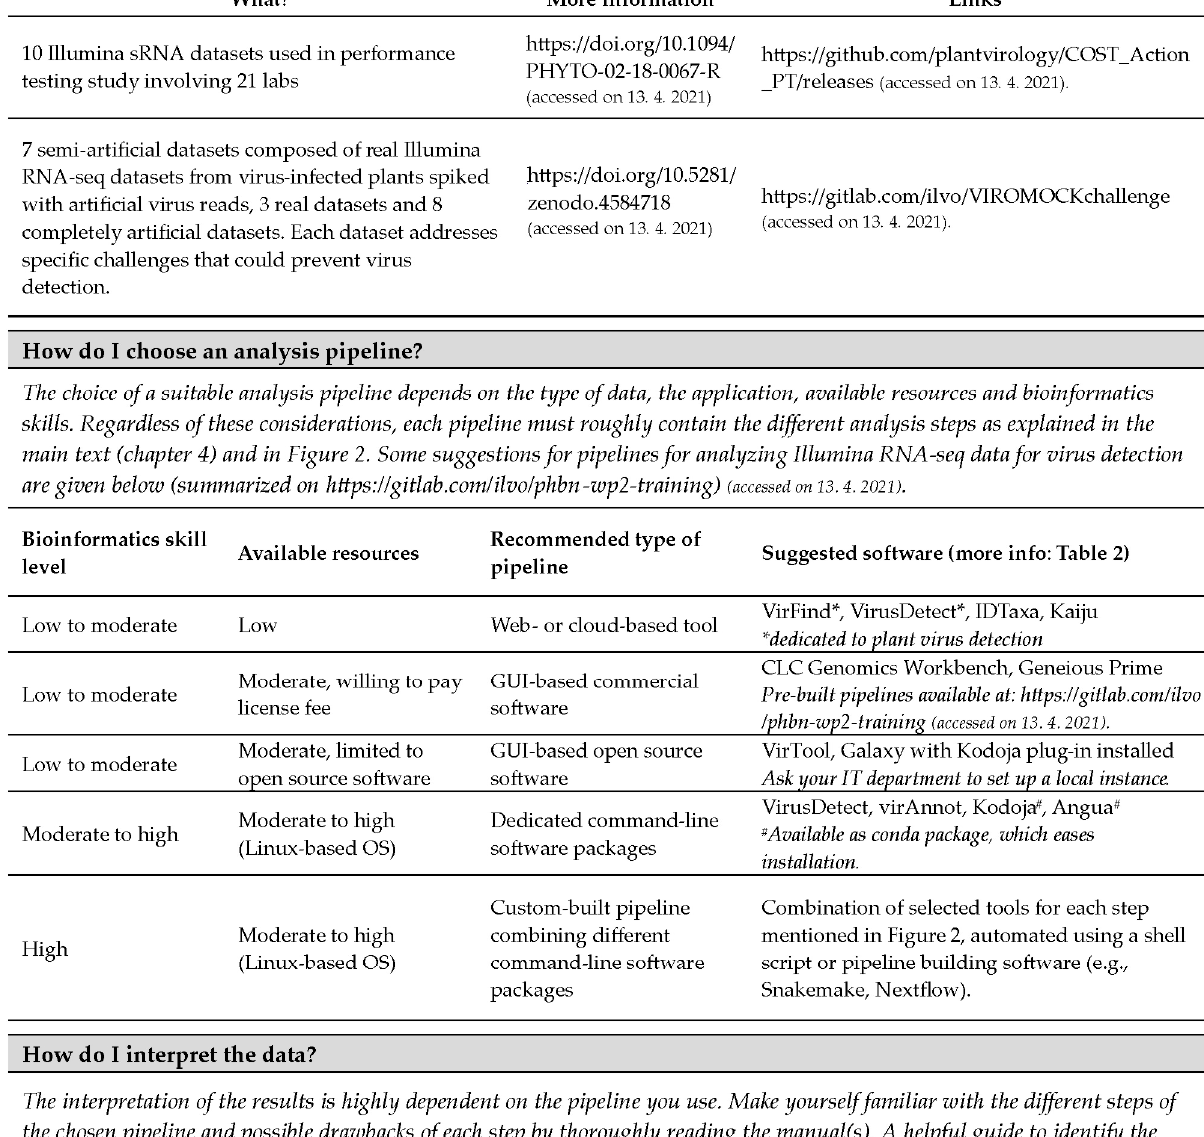
Figure 5. Quick-start guide assisting selection of analysis approaches for plant virus detection from HTS data.